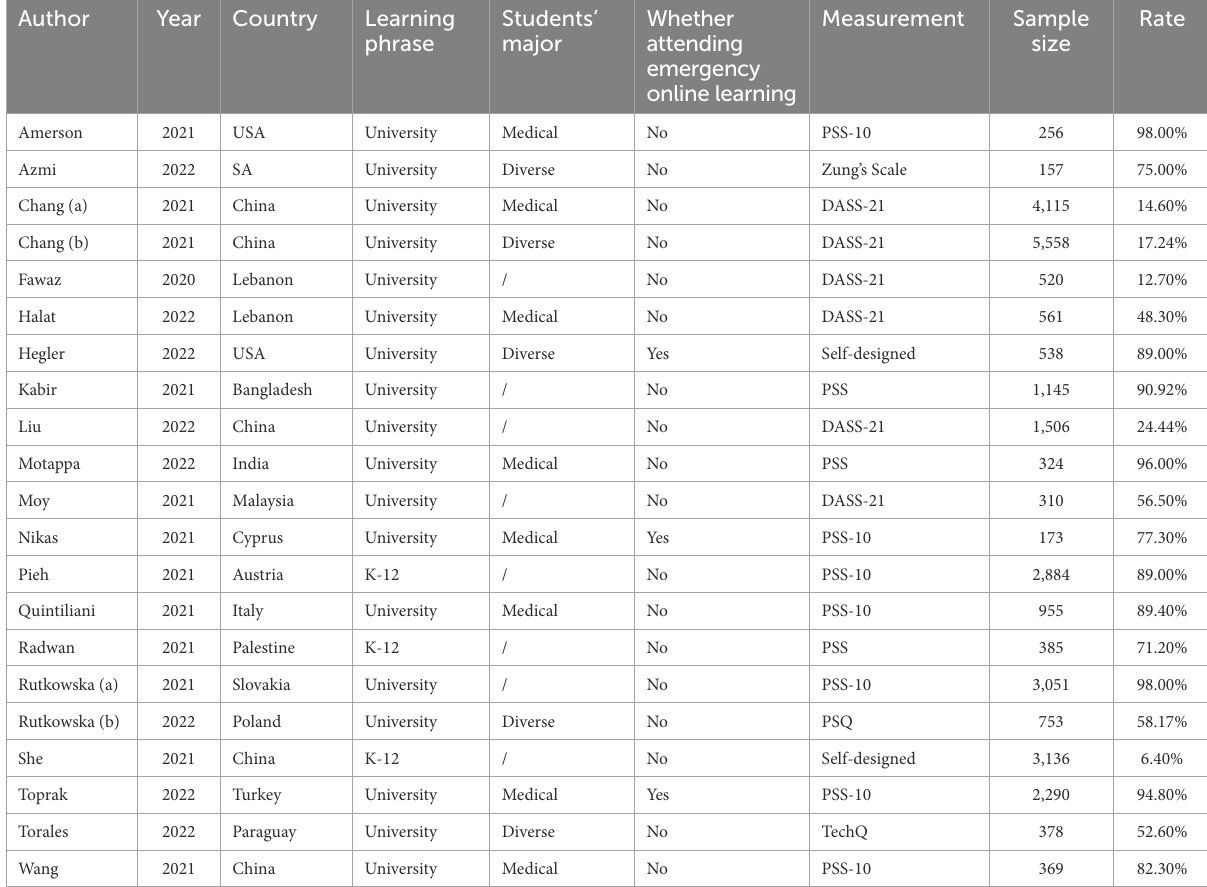
TABLE 3 Summary coding of included stress studies (arranged in alphabetical order of the first author).